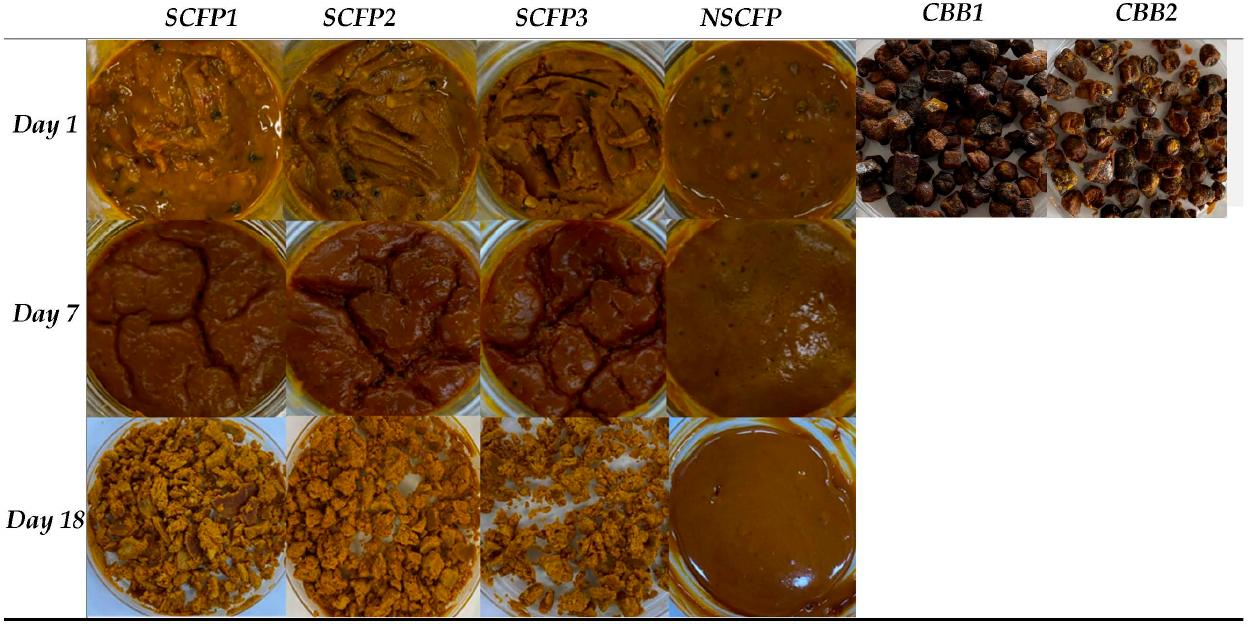
Figure 1. Visualization of pollen fermentation on days 1, 7 and 18. SCFP1: Starter-culture-fermented